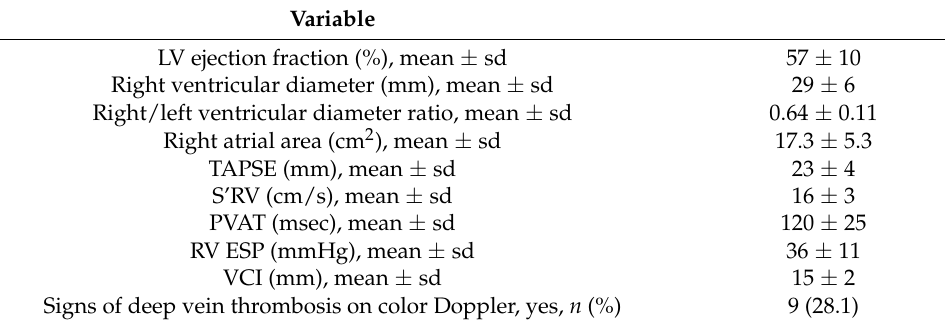
Table 5. Echocardiographic parameters of the study